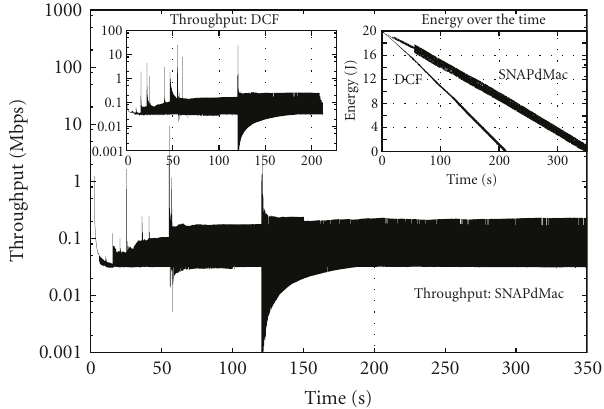
Figure 9: Throughput and energy performance (HD/C).